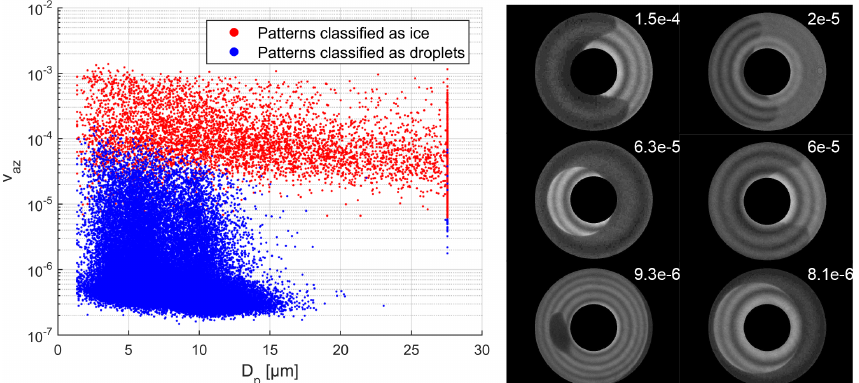
Figure 15. Image analysis for the period displayed in Fig. 13. Left panel: the variance of the polar integrated azimuthal profile as a function of the optical sphere equivalent diameter deduced from the trigger intensity for scattering patterns. For the automated classification a vari- ance threshold was applied. Subsequently, patterns with v az > 2 × 10 − 6 were manually crosschecked. Right panel: a selection of manually reclassified droplet patterns with artifacts. The v az values are displayed with the patterns.